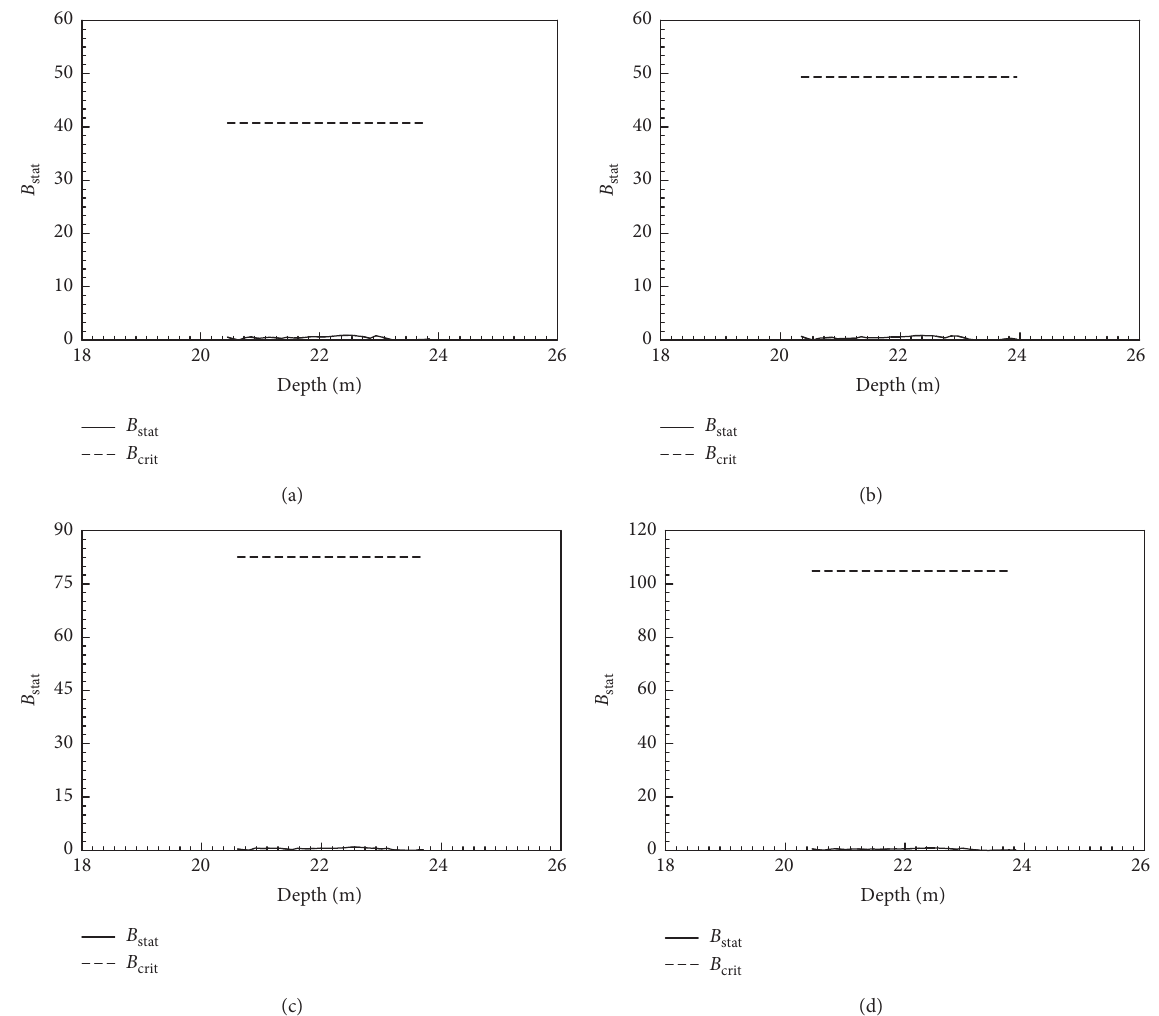
Figure 9: Validation of stationarity of r for the medium clay layer. (a) M